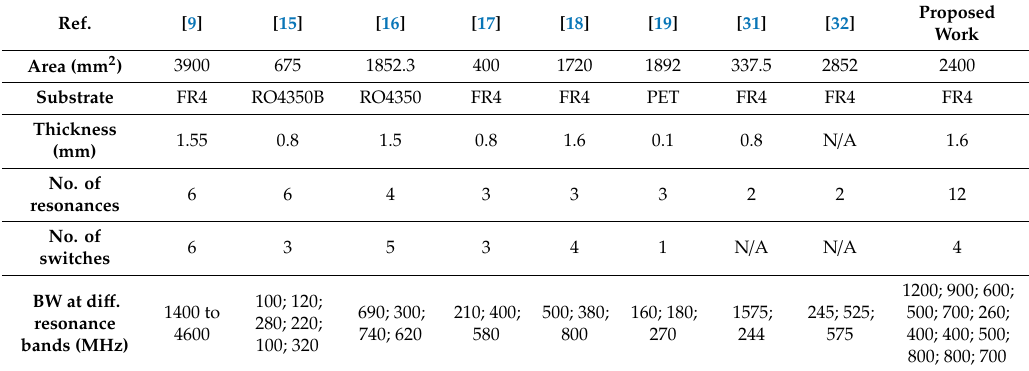
Table 9. Performance comparison with other designs in the